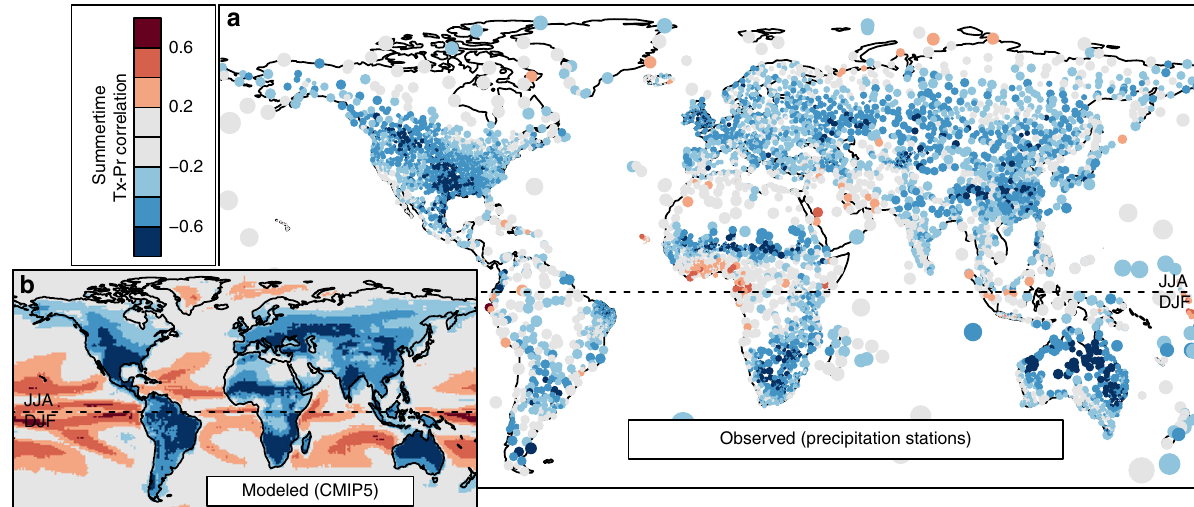
Fig. 5 Observed and modeled correlations between summer precipitation and mean daily maximum temperature. Spatial patterns in the correlation between mean daily maximum temperature (Tx) and precipitation (Pr) of the Boreal (JJA) and Austral (DJF) summer are generally consistent between a CRU TS3.23 44 precipitation stations and b the six-model ensemble mean of CMIP5 historicalNat simulations. To reduce overplotting, point size of precipitation stations is proportional to distance from the third nearest